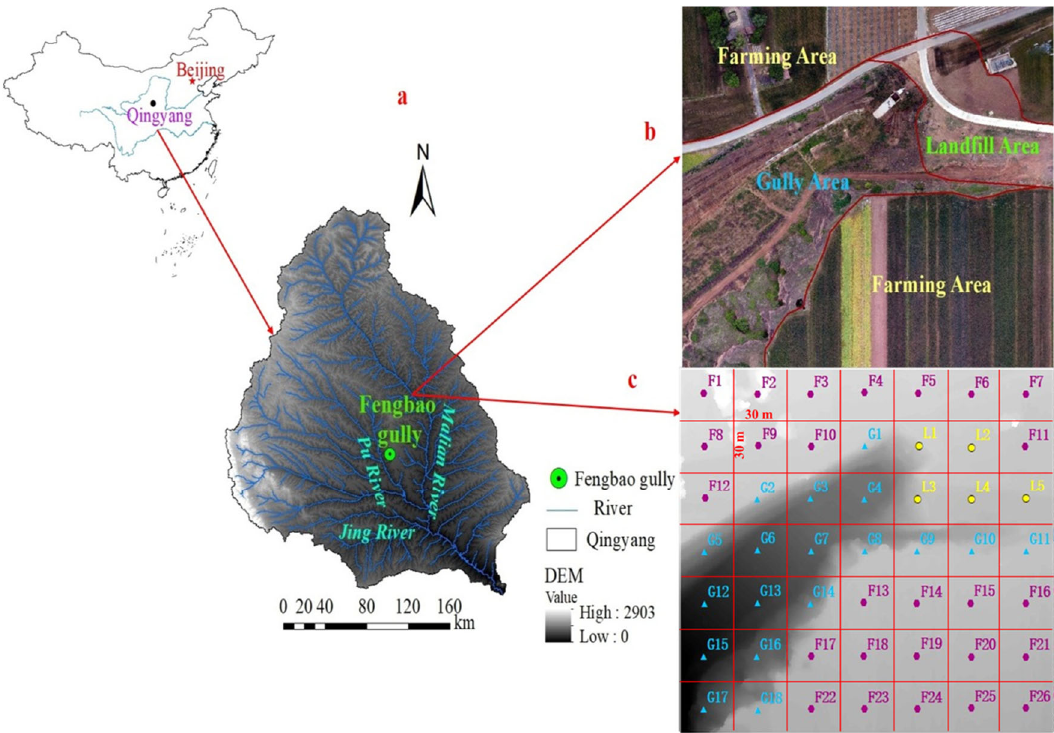
Figure 1. Location of the study area in China: ( a ) Location of sampling points; ( b ) Fengbao gully head is divided into Highland Farming (F), Gully Head Landfill (L), and Gully (G) areas; and ( c ) sample points are uniformly distributed in the highland farming, gully head landfill, and gully ar ‐ eas .